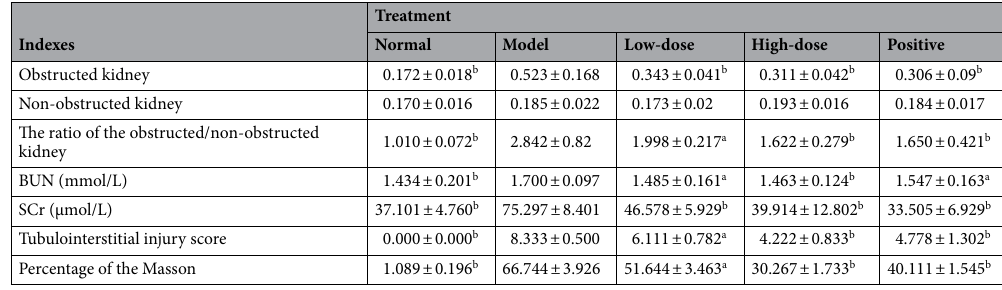
Table 1. Effect of COS on alleviating kidney injury in UUO mice model. COS improve kidney injury in UUO mice model. All values are represented as mean ± SD (n = 10 in each group). Superscript letters a and b designate significant differences. a P < 0.05 compared with the model group. b P < 0.01 compared with the model